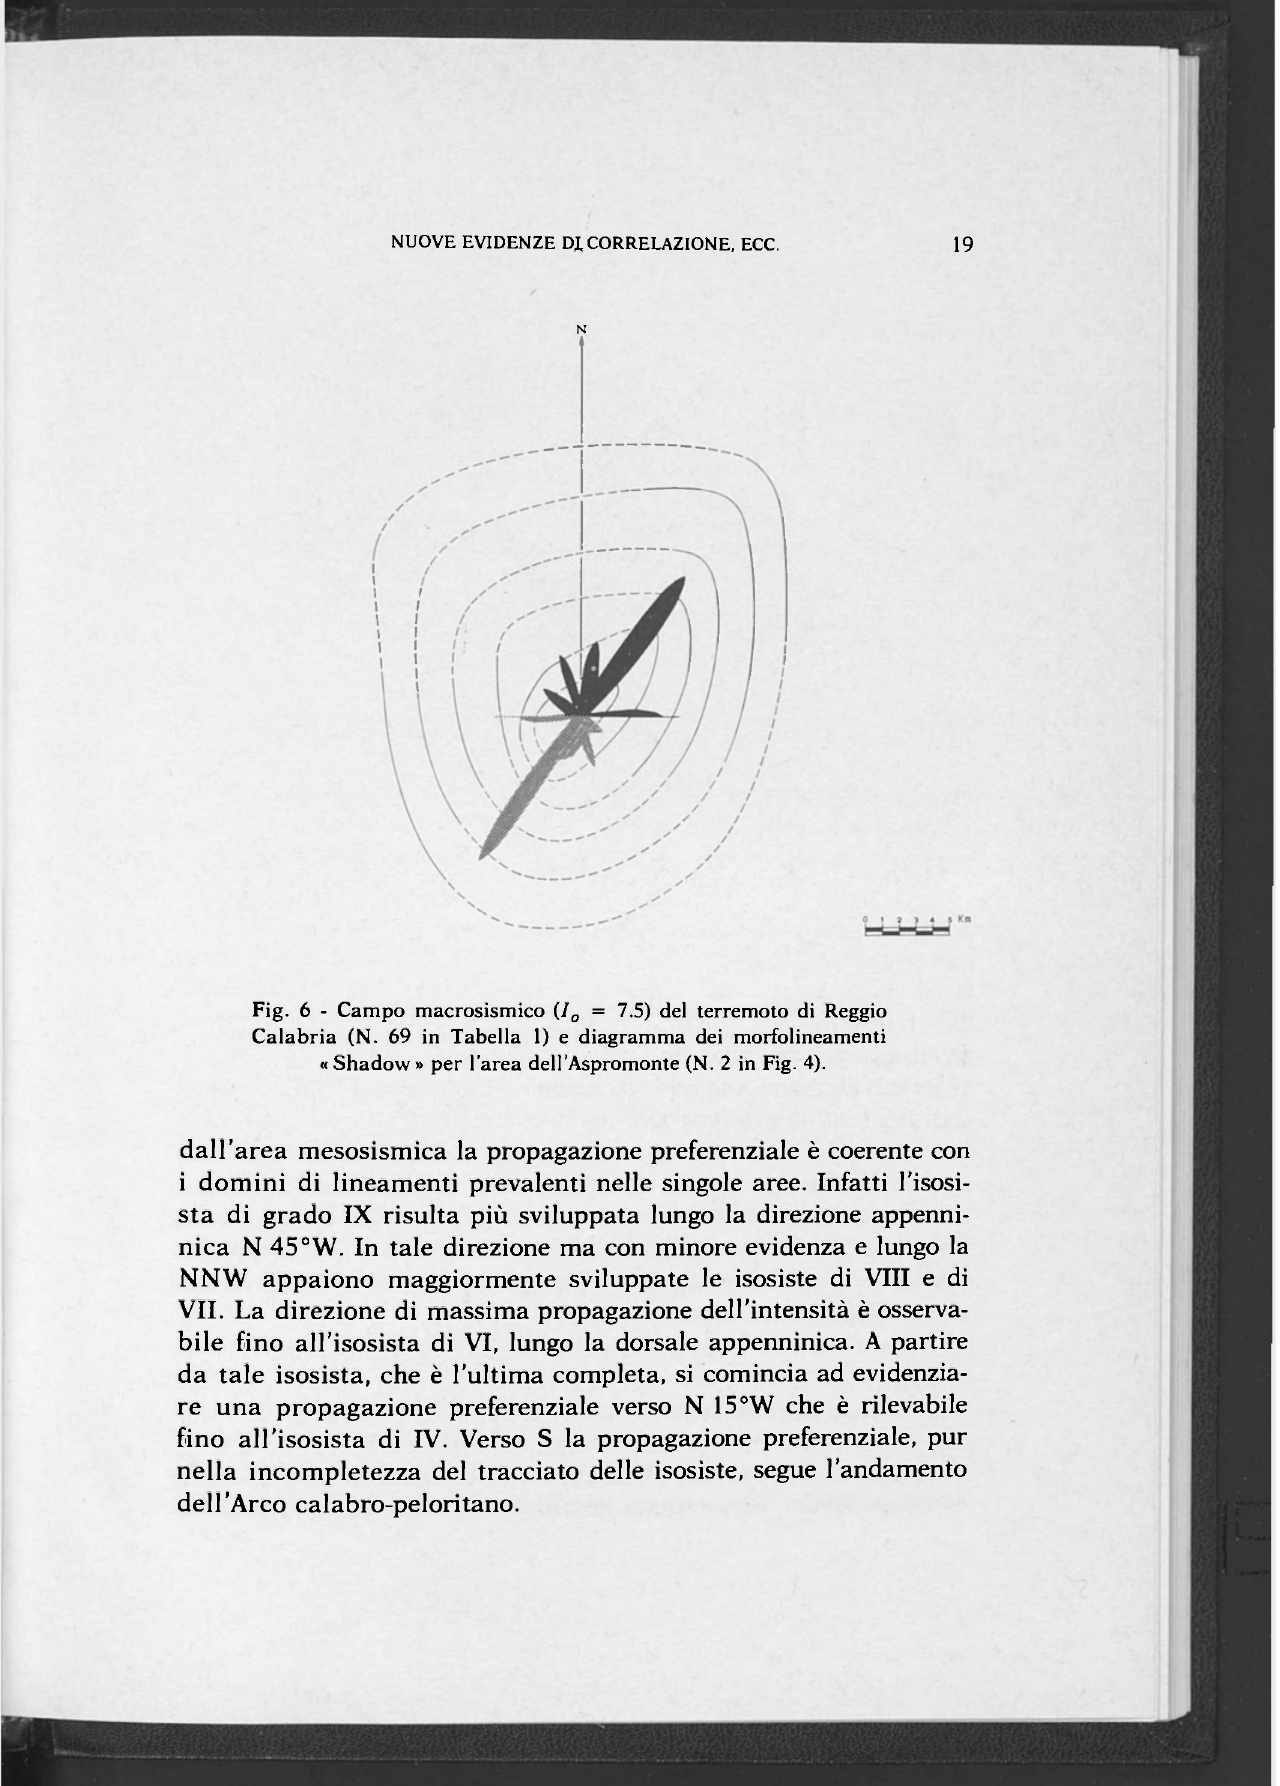
Fig. 6 - Campo macrosismico (/„ = 7.5) del terremoto di Reggio Calabria (N. 69 in Tabella 1) e diagramma dei